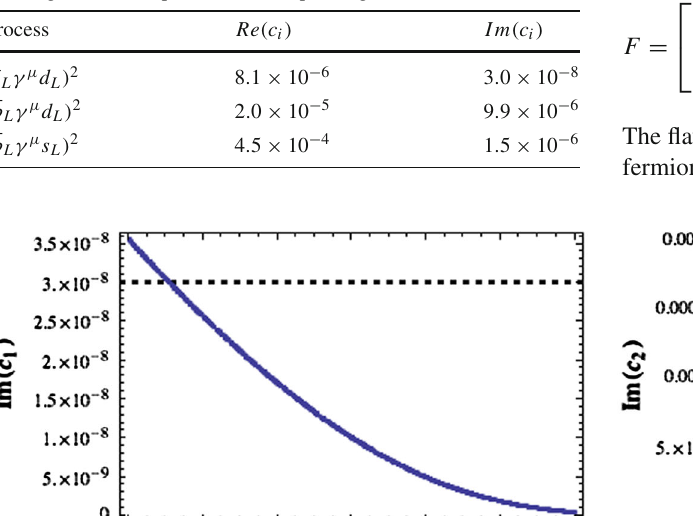
for s → d and b → d 3